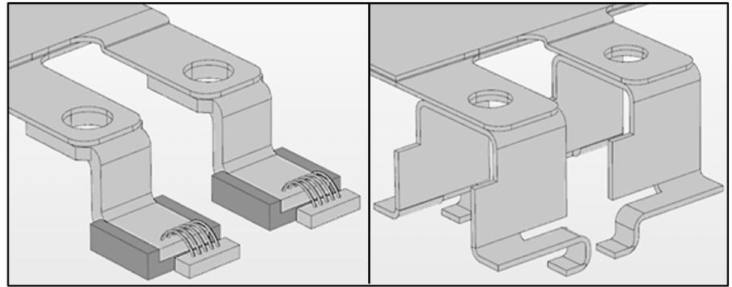
Figure 3. Power terminals geometries—Module M ( left )—Module K ( right